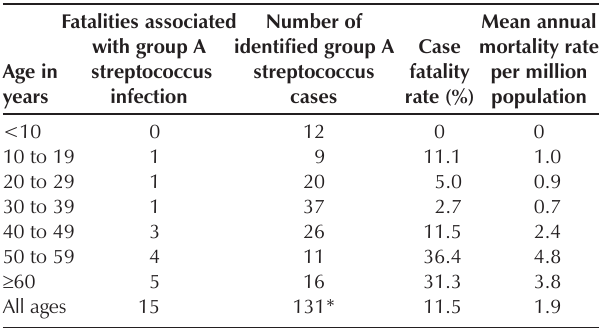
Invasive group A streptococcus mortality by age group in cases with available outcome information